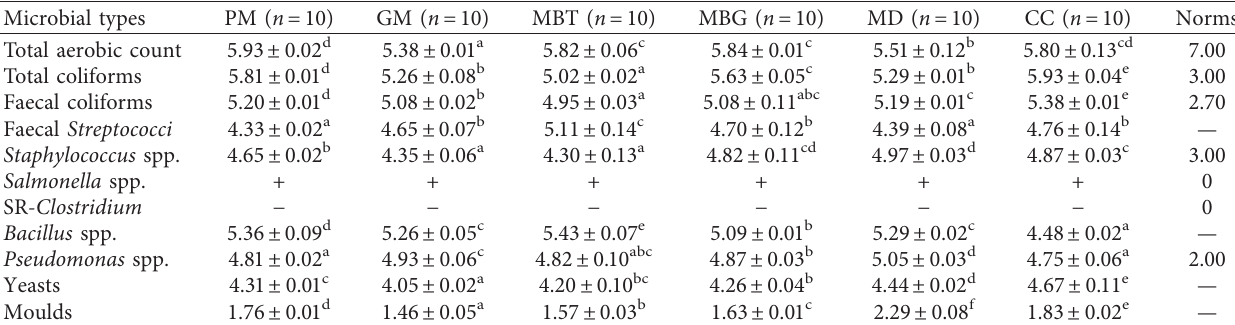
Table 1: Mean microbial loads in LogCFU/g of fresh beef samples collected from different markets of the city of Ngaound´er´e. Microbial